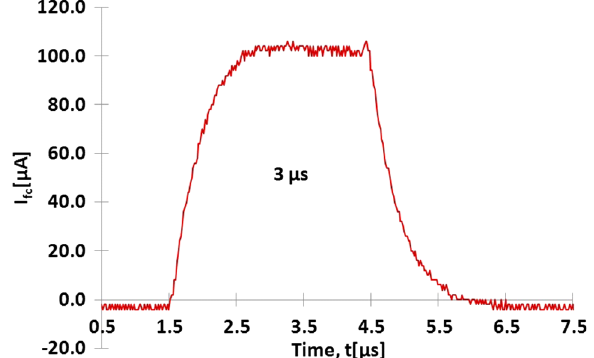
FIG. 11. He 1 þ ion beam pulse with a duration of 5 ms captured by the Faraday cup.